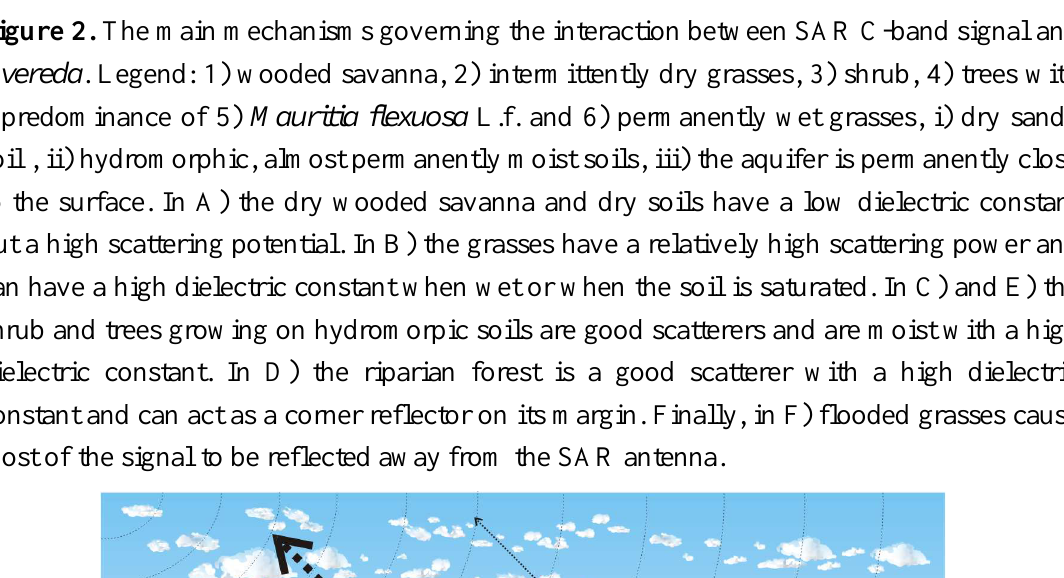
Figure 2. The main mechanisms governing the interaction between SAR C-band signal and a vereda . Legend: 1) wooded savanna, 2) intermittently dry grasses, 3) shrub, 4) trees